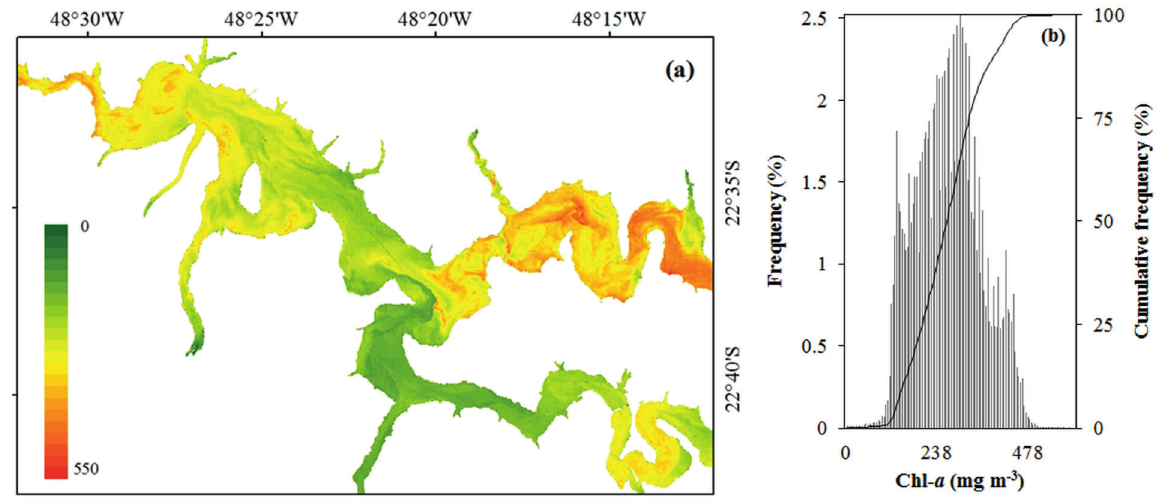
Figure 4 - ( a ) Map of Chl- a concentration based on the SLO model using quadratic fit and ( b ) frequency plot of occurrence of Chl- a